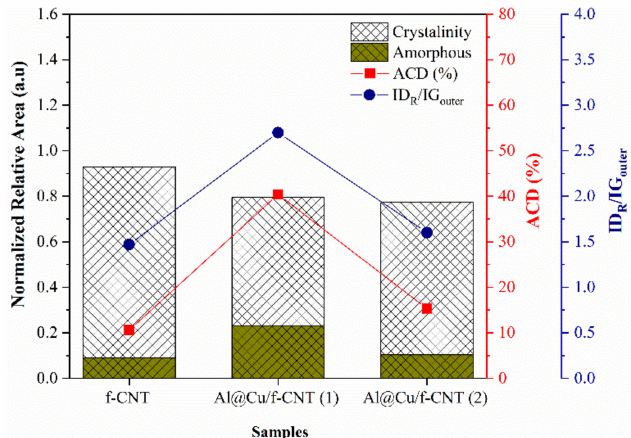
Figure 4. Peak intensity ratios related to defects and graphitization of the outermost tubes (dark blue balls) and the degree of amorphous carbon (red squares) obtained for different samples, with the relative areas normalized by the f-CNT area for crystallinity and